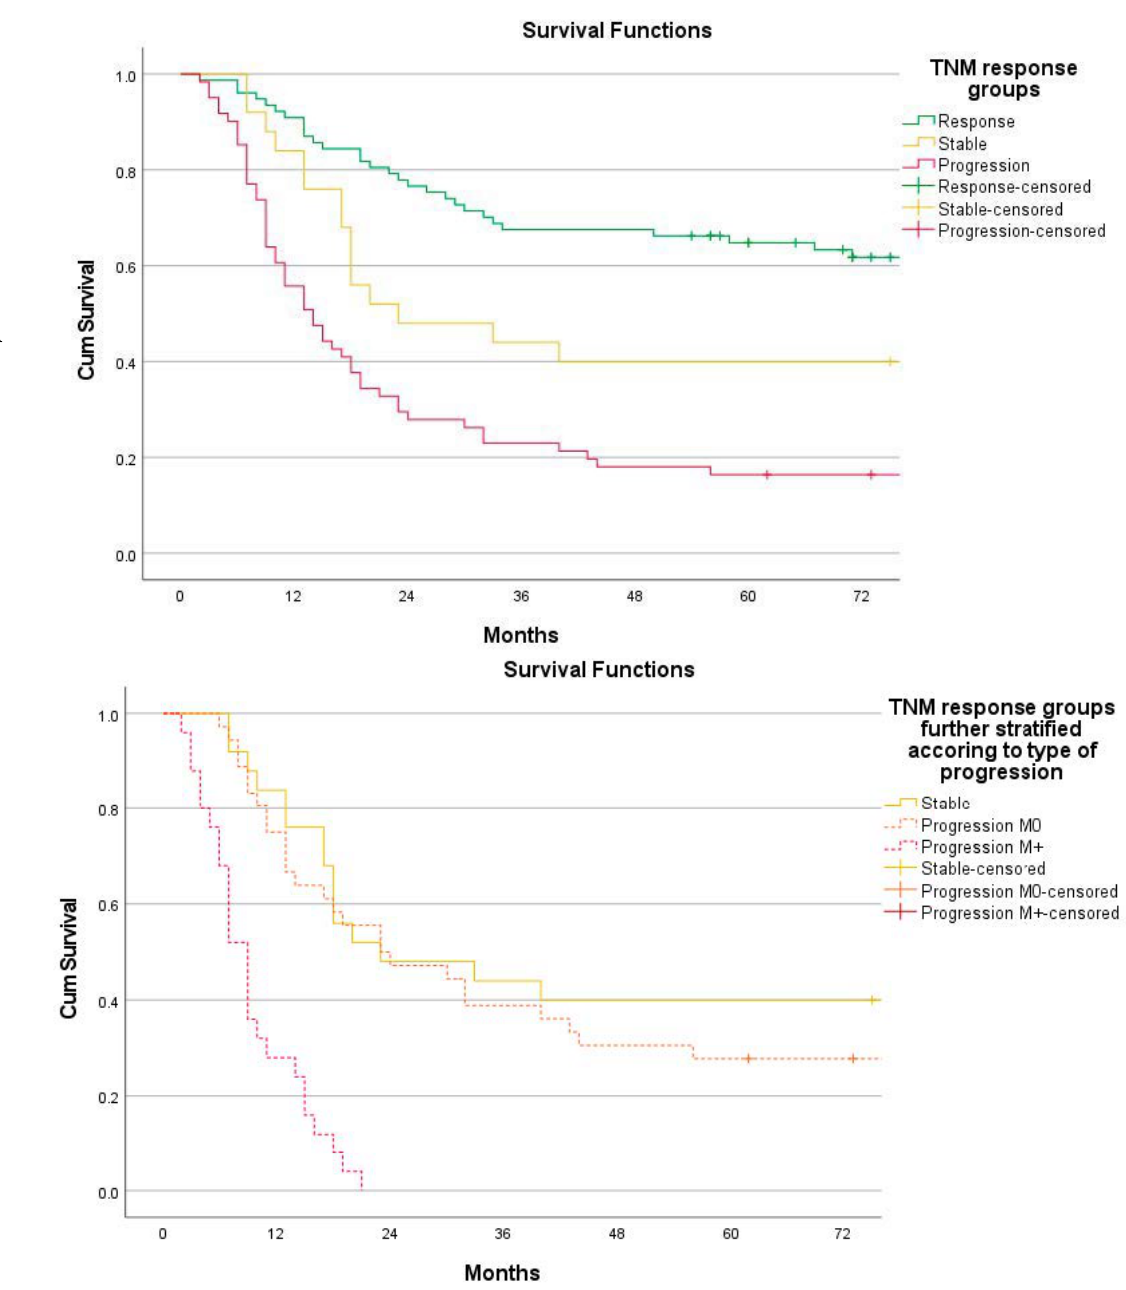
Figure 3. ( A ) Overall survival stratified on the basis of the TNM response mode, n = 164. Response ( n = 78), stable disease ( n = 25), and progression ( n = 61). Global log-rank p < 0.001. Response vs. stable p = 0.012. Stable vs. progression p = 0.020. ( B ) : Overall survival based on TNM response mode. Disease progression further subdivided into progression maintaining M0 status ( n = 35) and progression to metastatic disease M+ ( n = 26). Stable disease vs. progression maintaining M0, log-rank p = 0.512.